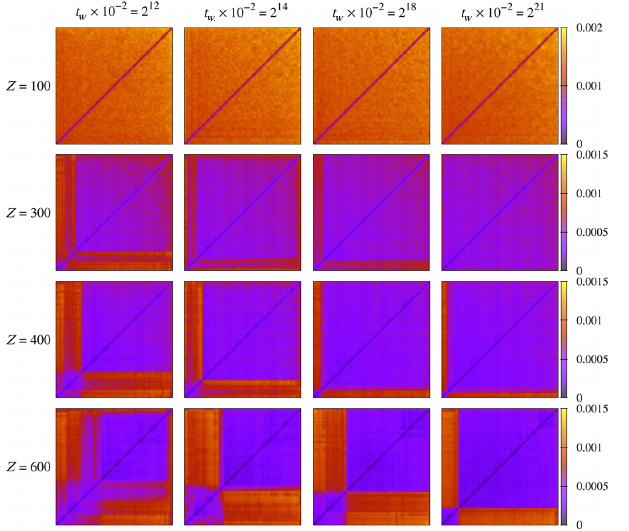
FIG. 7. Heat maps of distances between clones Δ α sample α with N ¼ 1024 , organized by N waiting time increases from left to right, the pressure from top to bottom, as indicated. Whereas the maps at Z ¼ 100 < Z featureless and time independent, they exhibit an organization into two sub-basins for Z ≥ 300 , which slowly disappears as t increases.